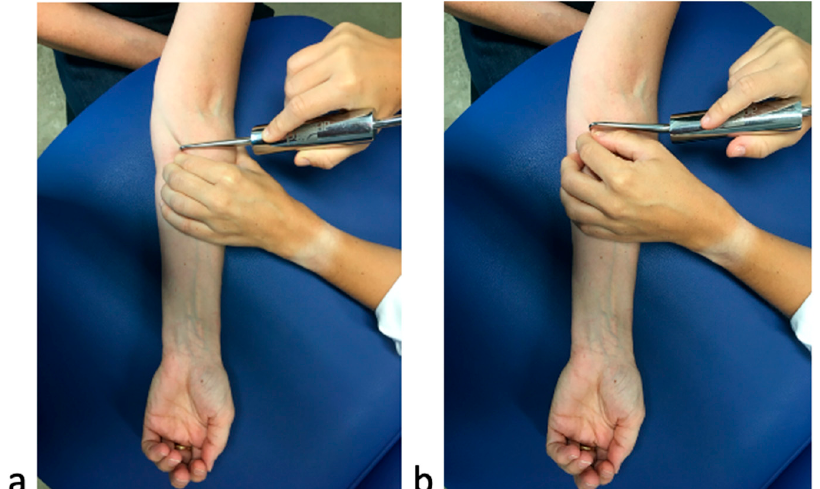
Figure 1. Application of independent variable (( a ) Diacutaneous Fibrolysis: DF application on teres major muscle and ( b ) sham technique: sham application on superficial tissues).